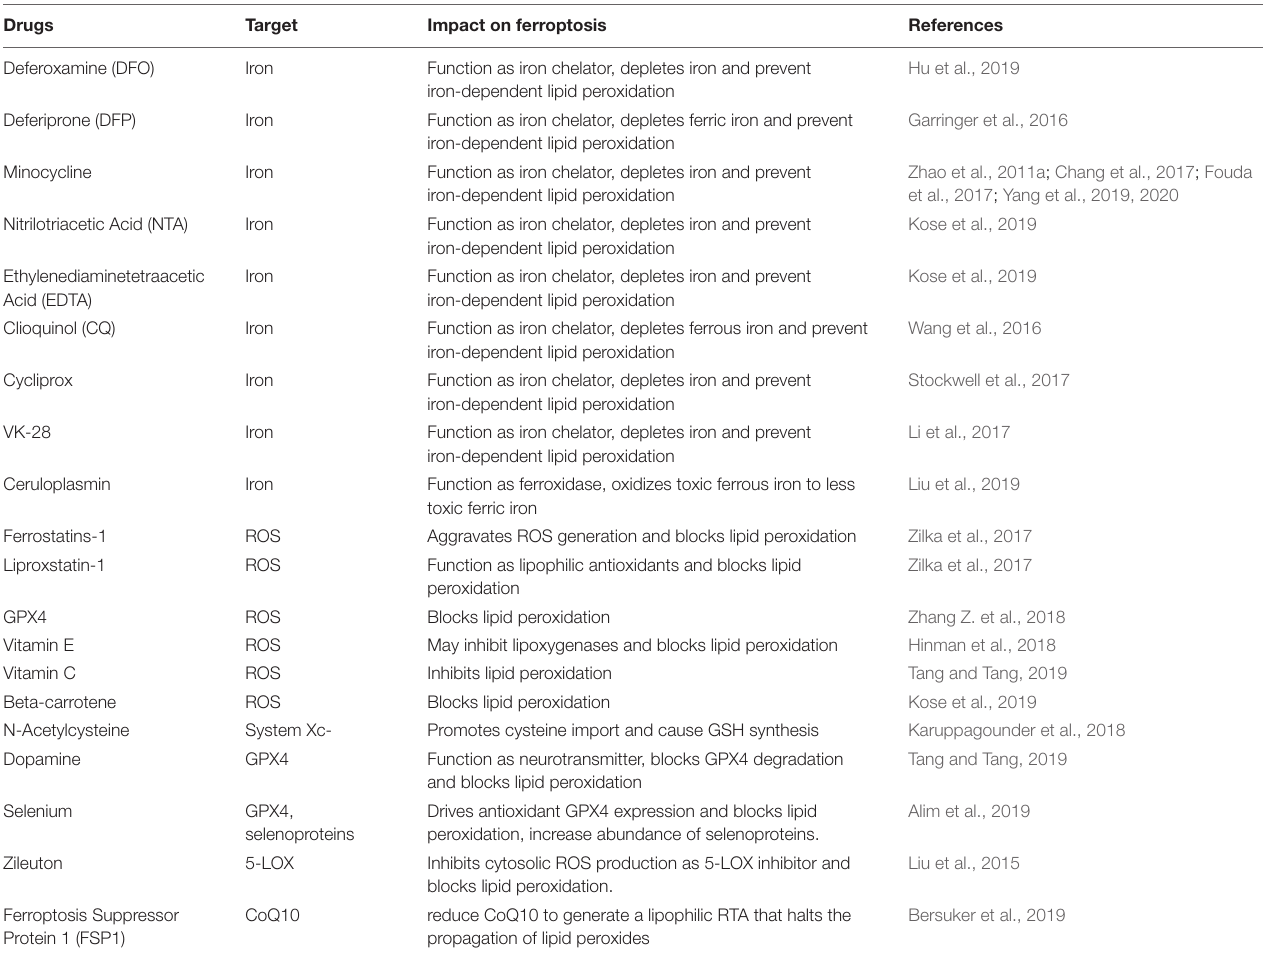
TABLE 2 | Promising anti-ICH drugs that target